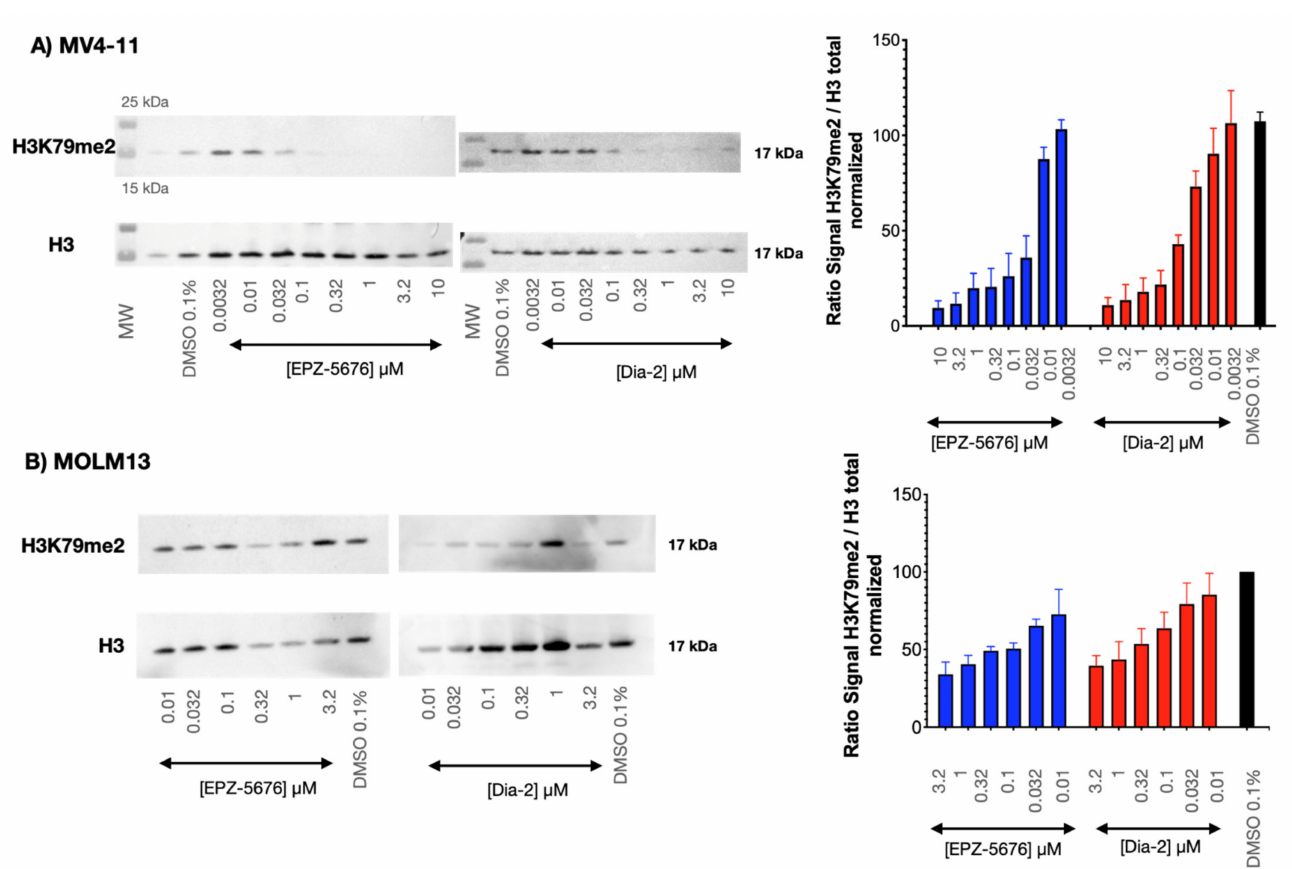
Figure 7. ( A ) MV4-11 and ( B ) MOLM13. The percentage of dimethylated H3K79 lysine measured by Western blot of harvested histones of MV4-11 cells after treatment with Dia2 (red) and EPZ-5676 (in blue). A representative Western blot is shown as an example. The values are the mean results of at least biological triplicated and correspond to the normalization to the H3K79me2 signal to the histoneH3 signal, as a percentage of methylation compared to DMSO-treated cells. MV4-11 cells were treated 4 days and MOLM-13 6